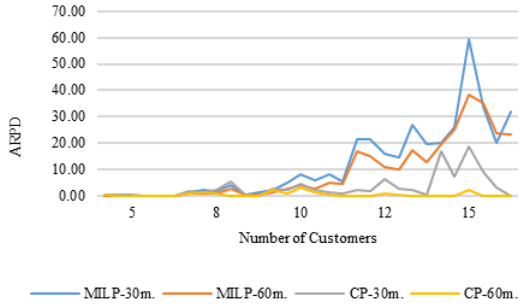
Figure 1. ARPD results of MILP and CP models under 30- and 60- minutes limits.